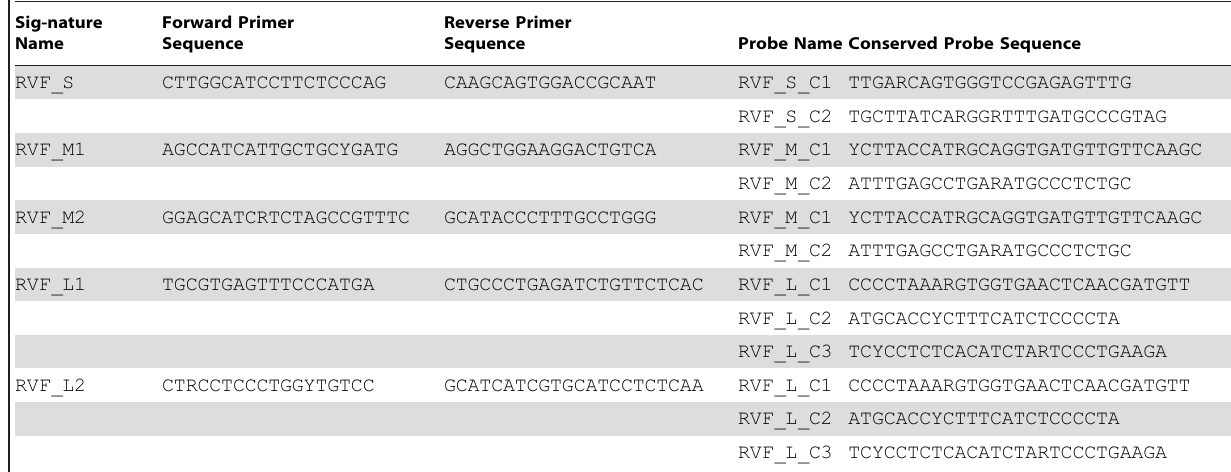
Table 2. Rift Valley Fever (RVF) Degenerate Assay Signatures.